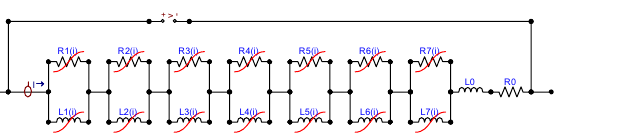
Figure 2. Lumped Element Equivalent Circuit (LEEC) model given by formula (3) proposed in 10 to reproduce Z (cid:31) f , i DC (cid:30) characteristics shown in Fig.